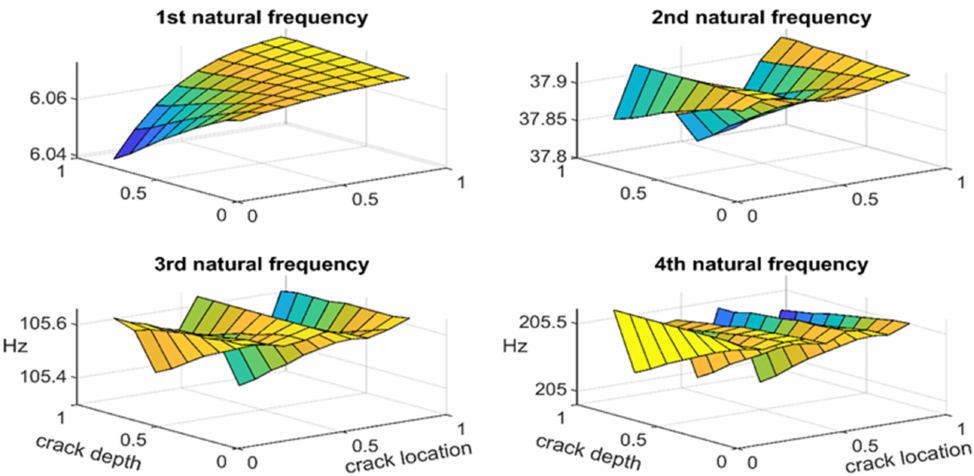
Figure 10. Natural frequency variations in function of crack depth and location.